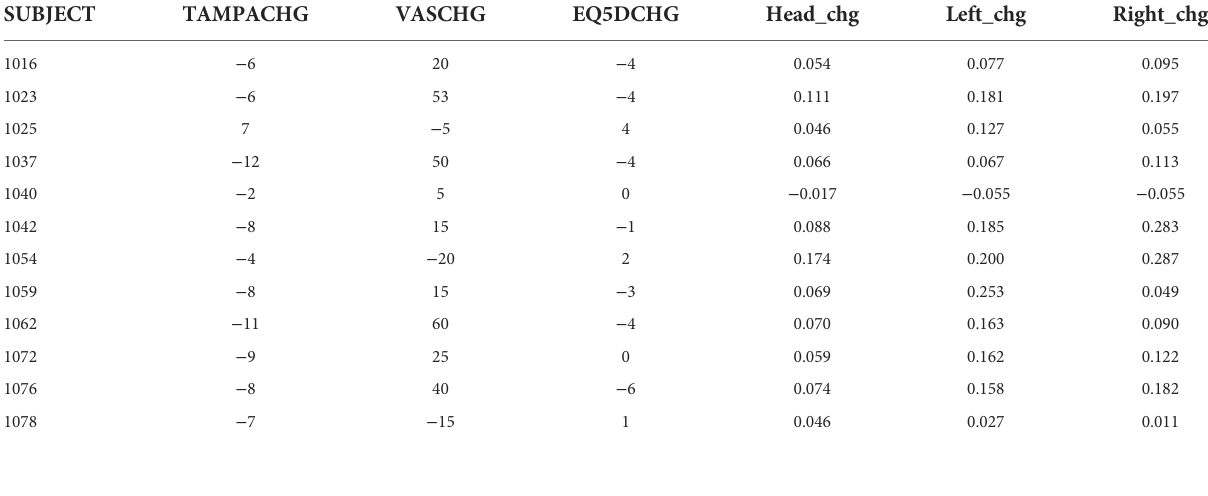
TABLE 1 Average velocity change as “ slope value * study days ” in the controllers (Right, Left, Head) and the change in Clinical assessments (Tampa Scale of Kinesiophobia (TAMPACHG), Overall health Visual analogue scale (VASCHG), EuroQoL-5D-5L QoL score (EQ5DCHG) during the study for each participant in DTxP arm.